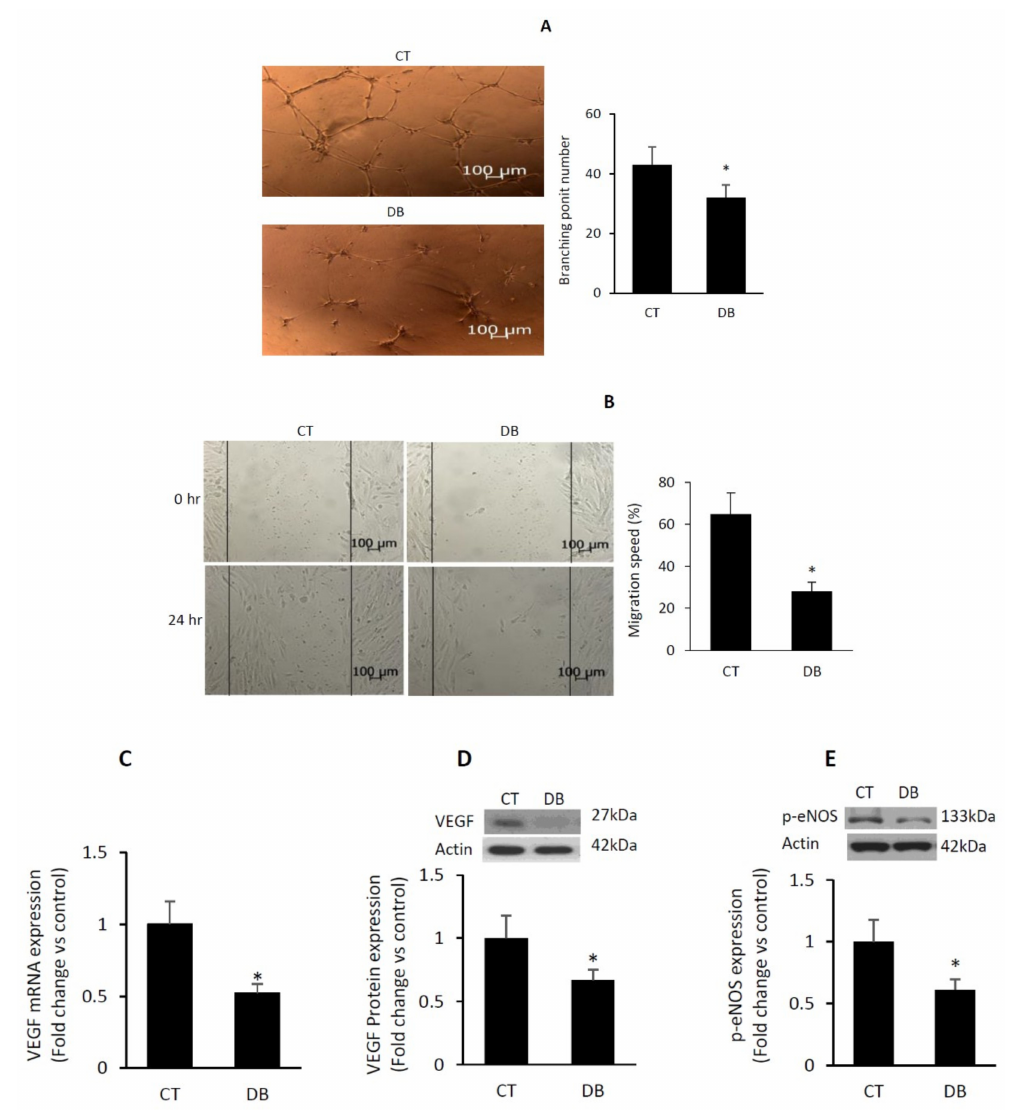
Figure 2. Diabetes suppresses angiogenic capacity in W-ECs. ( A ) Photomicrographs of tube formation of W-ECs that were seeded on growth factor-reduced Matrigel; accompanied by a barograph figure denoting the quantitative measure of the branching point number. ( B ) Photomicrographs of cell migration (e.g., scratch of cells with a pipette tip) followed by light microscope-based measurement of the distance of wound covered by cells; accompanied by a barograph figure indicating the quantitative measure of migration speed expressed as percent of closure. ( C , D ) VEGF expression in terms of mRNA and protein levels was measured using qRT-PCR and Western blotting-based techniques. ( E ) p-eNOS, a measure of eNOS activity, was determined by Western blotting. Abbreviation: W-EC, wound endothelial cells; VEGF, vascular endothelial growth factor; p-eNOS, phospho-endothelial nitric oxide synthase; CT, control; DB, diabetic. Values are means ± SEM ( n = 6) * Significantly different from corresponding control values at p ≤